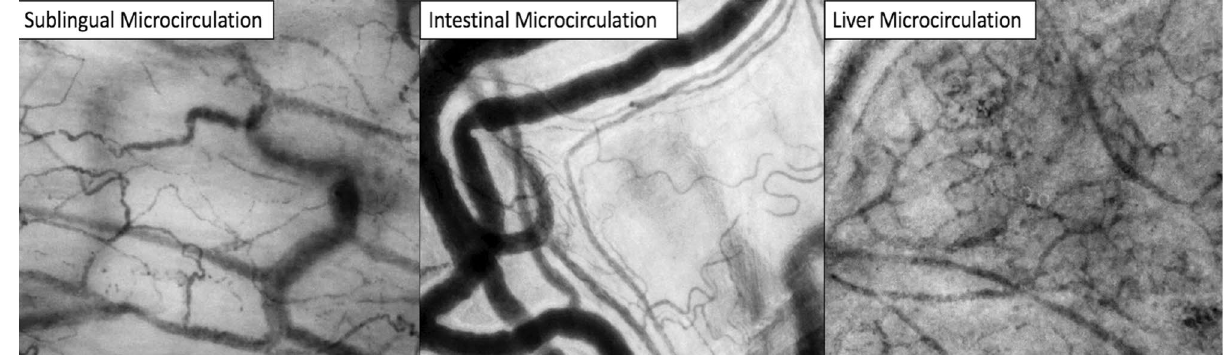
Figure 1. Screenshots of sublingual, intestinal and liver microcirculation, respectively, obtained by incident dark field handheld video microscopy. Dimensions of the field of view of the microcirculatory images is 1.55 mm × 1.16